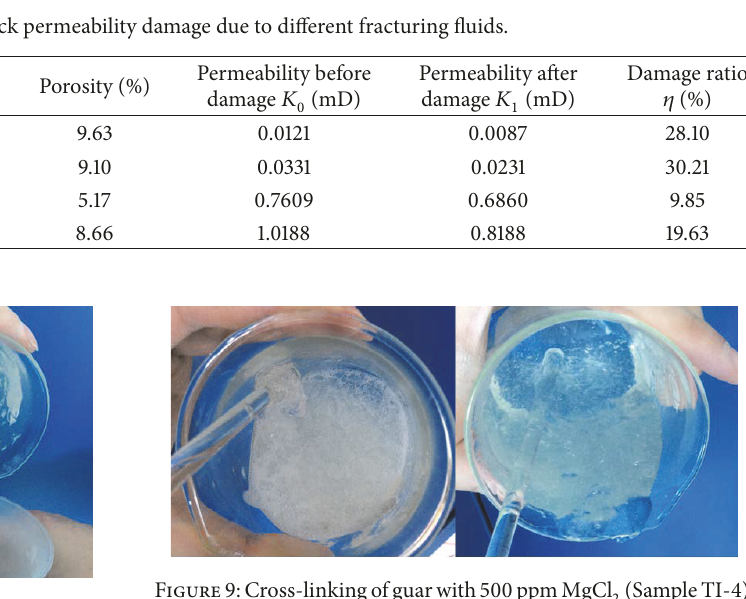
Figure 8: Cross-linking of guar with 500 ppm CaCl 2 (Sample TI-3).